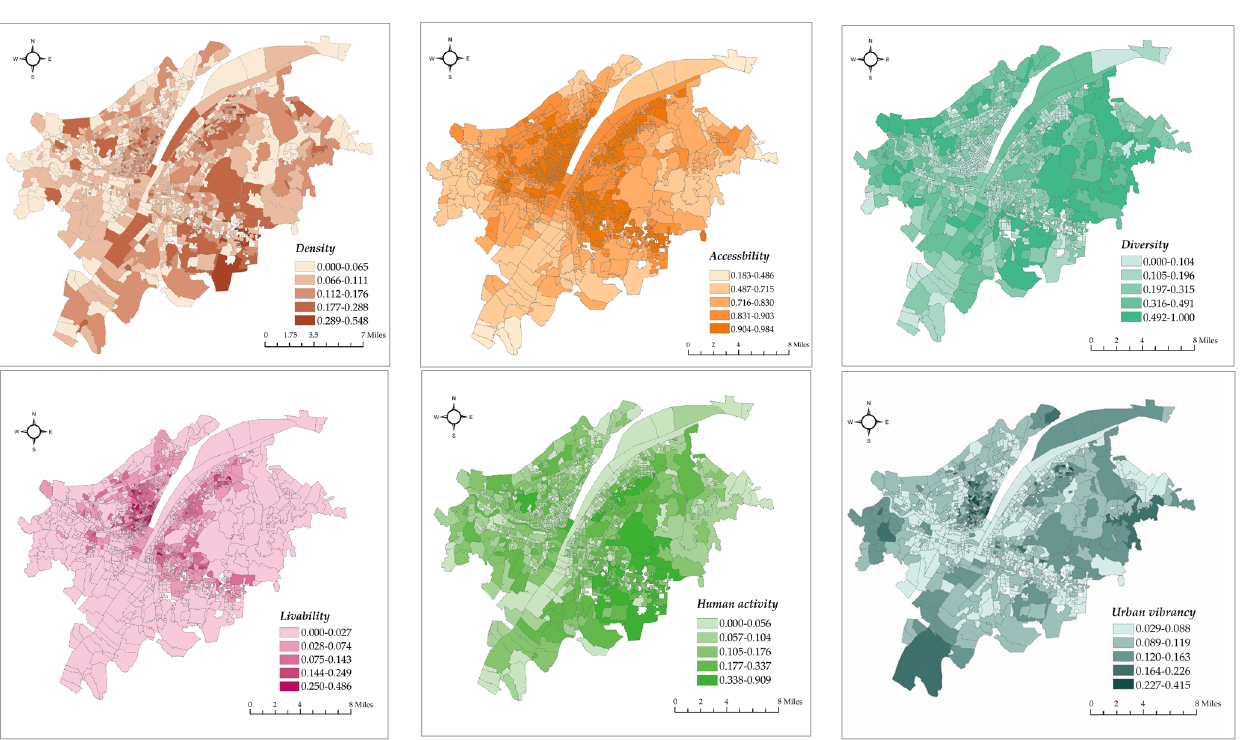
Figure 2. Spatial distribution of the values of urban vibrancy and of its dimensions.